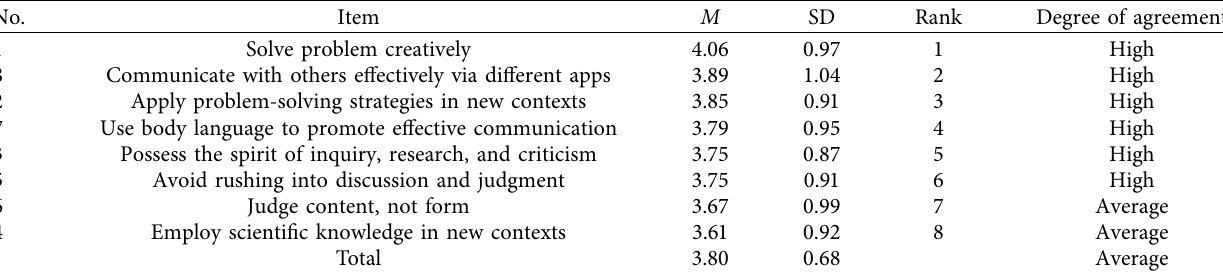
Table 10: Descriptives of soft skills in descending order.